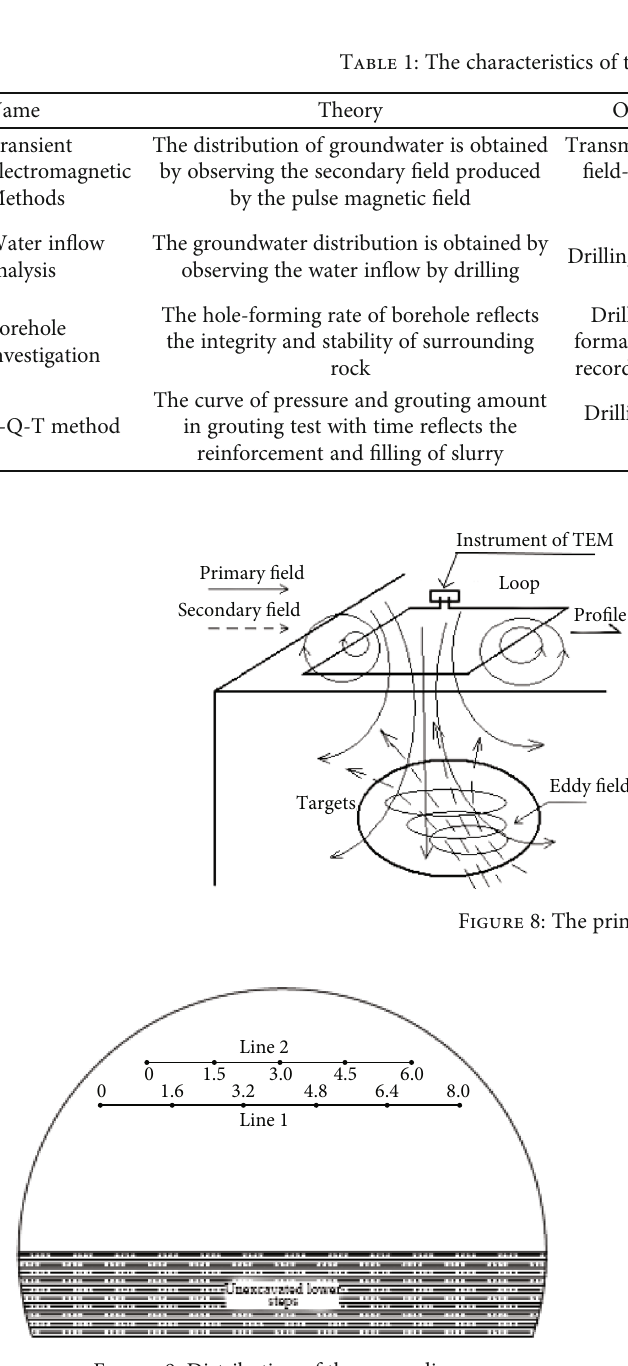
Figure 9: Distribution of the survey